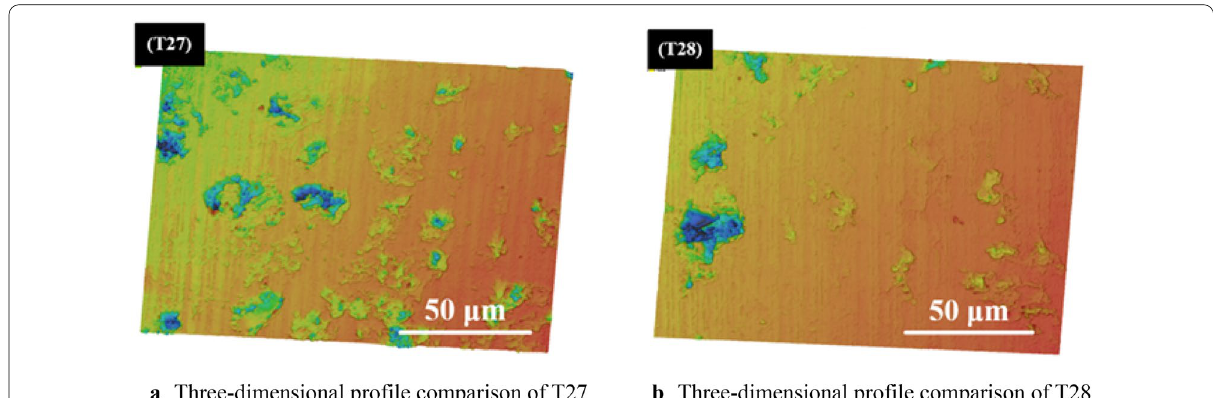
Figure 13 Three-dimensional profile comparison of T27 and T28